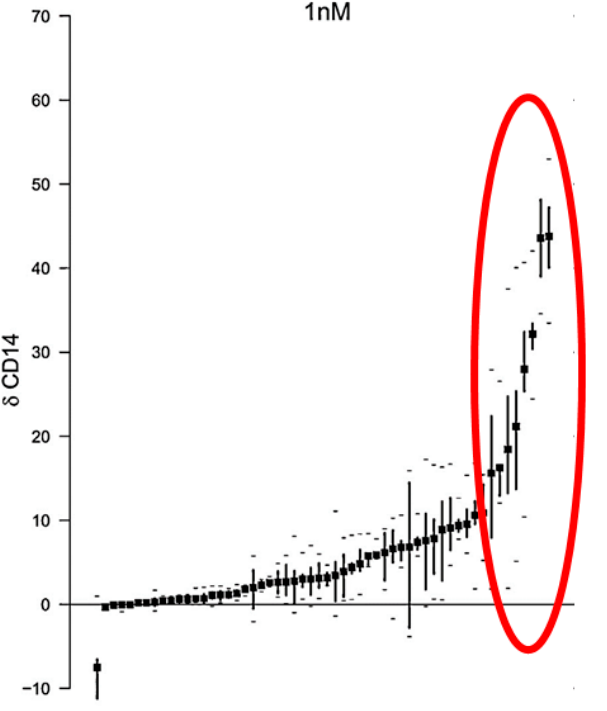
Figure 4. The monocytic differentiation of blasts from AML patients in response to 1 nM 1,25D and 1 nM analogs. The blasts of AML patients were isolated from peripheral blood and exposed to either 1 nM 1,25D or to one of the eight low-calcemic analogs at 1 nM concentration. Mean gain in expression of CD14 cell surface antigen for each patient is presented as a dot ( • ). Quartiles of response are marked by vertical lines, while minimum and maximum values are marked by dashes (–). Red oval surrounds the data from patients whose blasts were susceptible to 1,25D and to analogs. Adapted from [72].